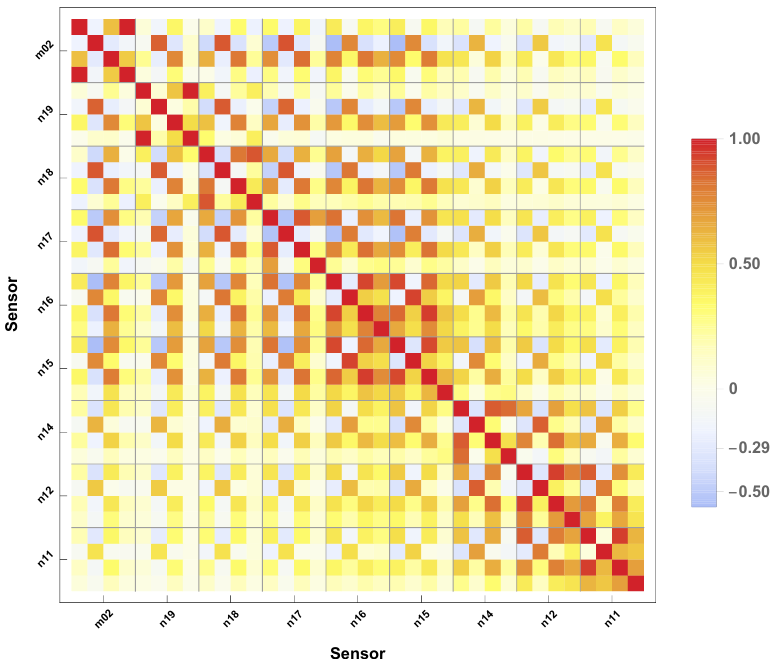
Figure 2. Error correlation matrix of harmonised calibration parameters. Thin horizontal and vertical lines separate the symmetric matrix into blocks of four by four pixels. Each block is associated with different sensors as indicated by mnemonic labels along the horizontal and vertical axis. Pixels inside diagonal blocks represent intra-sensor error correlations, whereas pixels inside off-diagonal blocks represent inter-sensor error correlations. Each off-diagonal pixel indicates how the errors in two different calibration parameters are